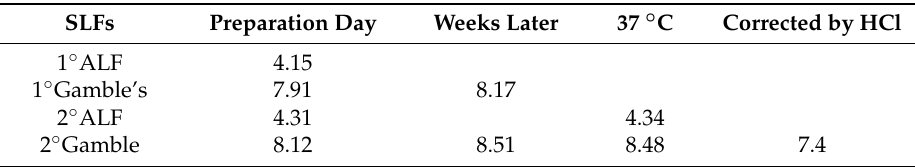
Table 1. Measured pH values of the prepared lung fluid solutions.